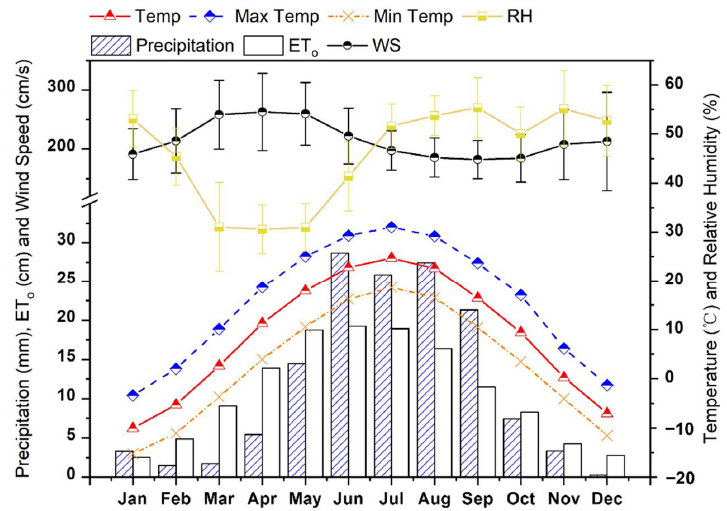
Figure 2. Seasonal pattern of precipitation, average, maximum and minimum temperature (Temp), wind speed (WS), relative humidity (RH), and reference evapotranspiration (ET o ) in the Jiefangzha Subdistrict.